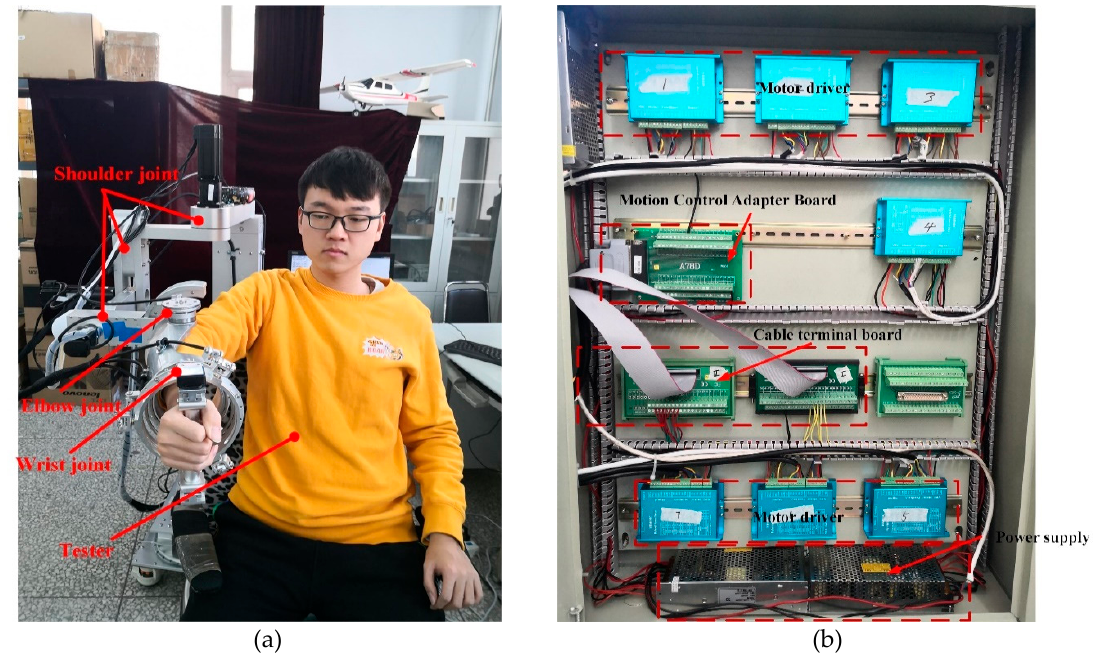
Figure 13. Test and control system diagram of rehabilitation robot. ( a ) Tester wearing prototype test; ( b ) physical map of control system.